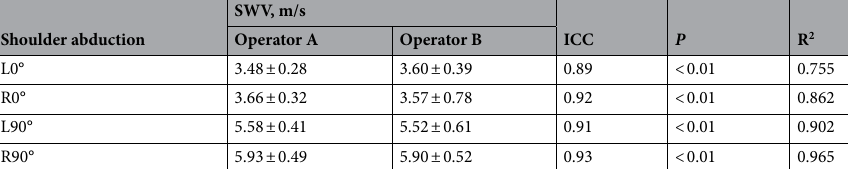
Table 3. Inter-operator reproducibility of mean shear wave velocity of the MD at various arm abduction. SWV mean shear wave velocity, ICC intra-class correlation coefficient, R 2 = goodness of fit. Data are presented as mean ± standard deviation where applicable.